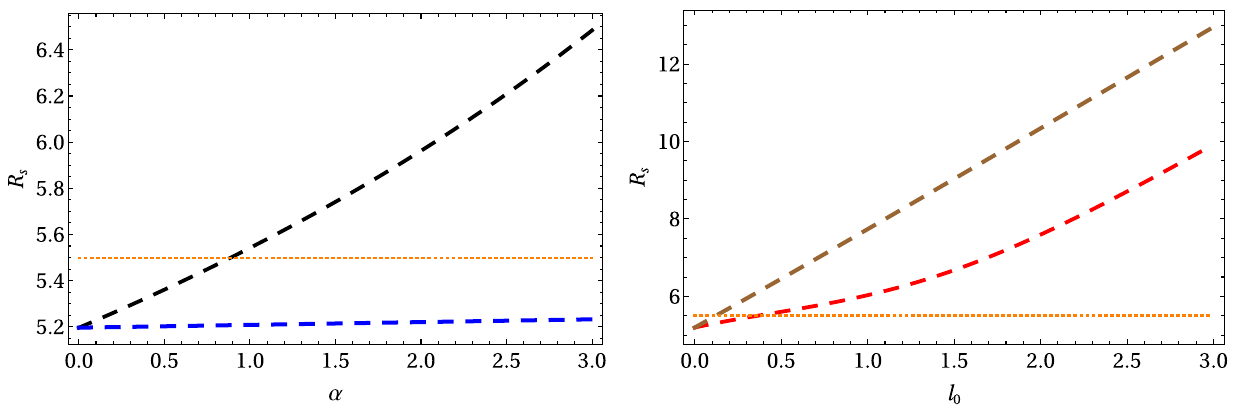
Fig. 1 Typical radius of the shadow, R s as function of α for models 1 (black line) and 2 (blue line) in the left panel and as a function of (cid:4) 0 for model 3 (red line) and 4 (brown line) in the right panel. The horizontal orange line corresponds to R s = 5 . 49874 for M87 BH as discussed in the text 2 QNM by the WKB